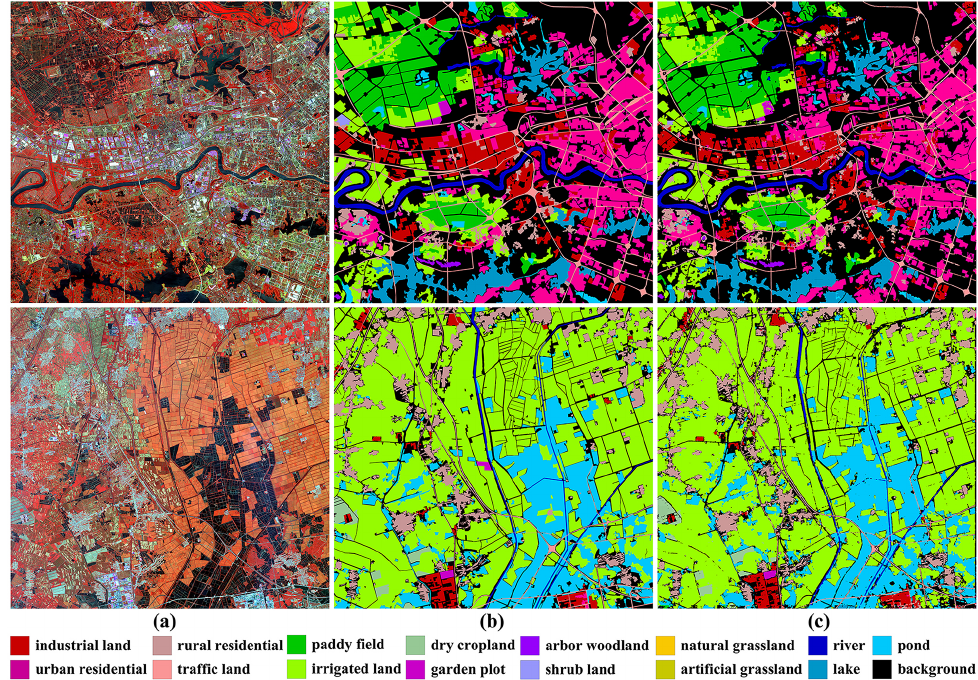
Figure 8. The segmentation result of XANet on the FLC dataset: ( a ) Image; ( b ) Ground truth; and ( c ) Segmentation